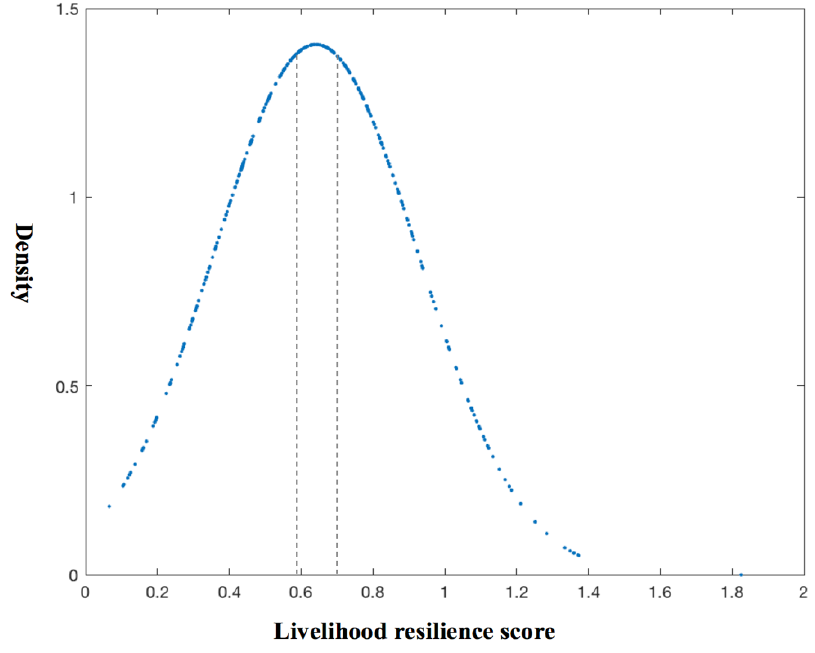
Figure 4. Density of livelihood resilience scores for the livelihood resilience measurement (LRM) framework. Source: designed by the